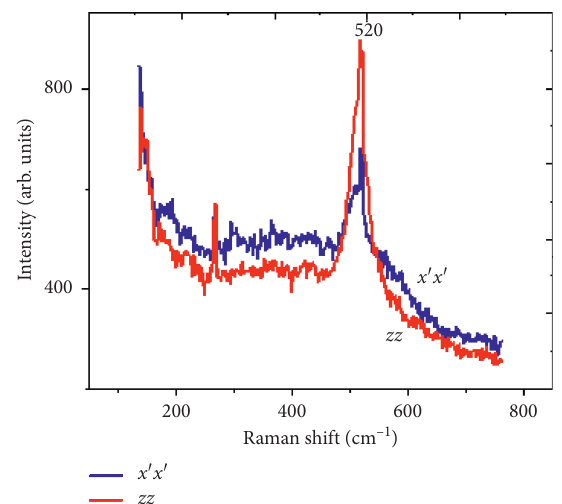
Figure 8: zz and x ′ x ′ polarization Raman spectra of (110)-oriented Ni doped PBCO thin